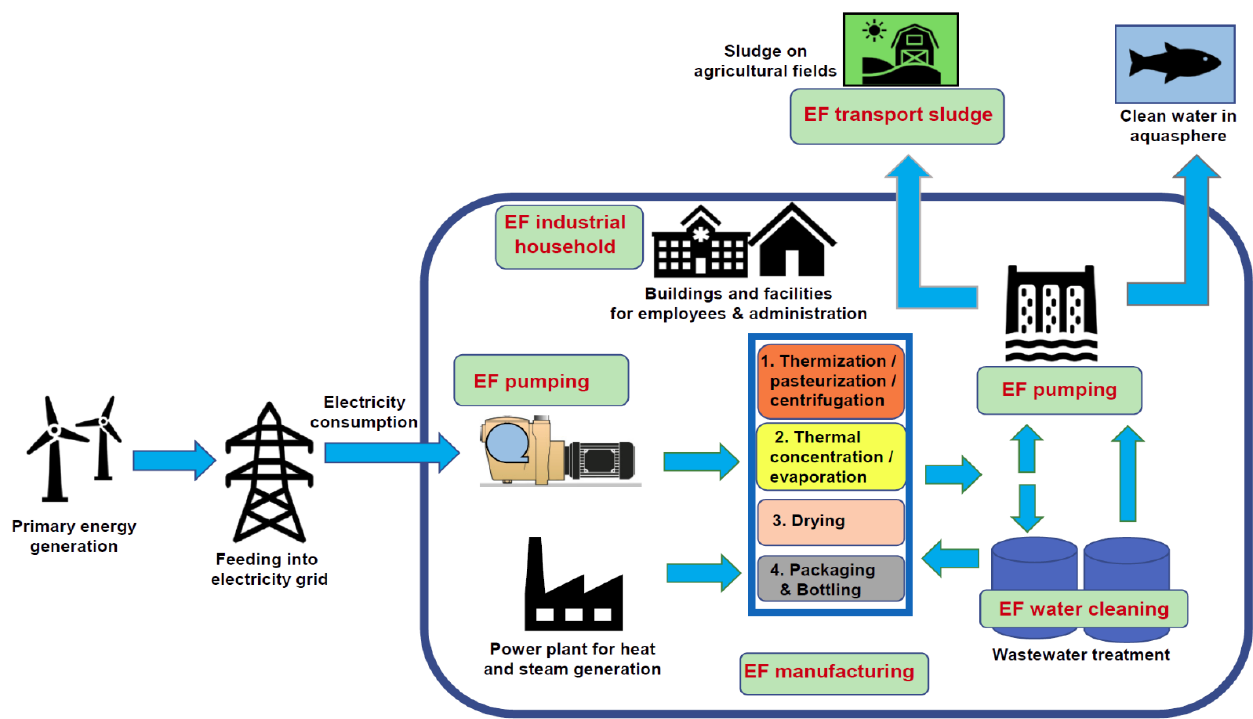
Figure 3. Supply chain of milk dairy–system boundaries using the presented life cycle assessment methodology and classification of the production stages.